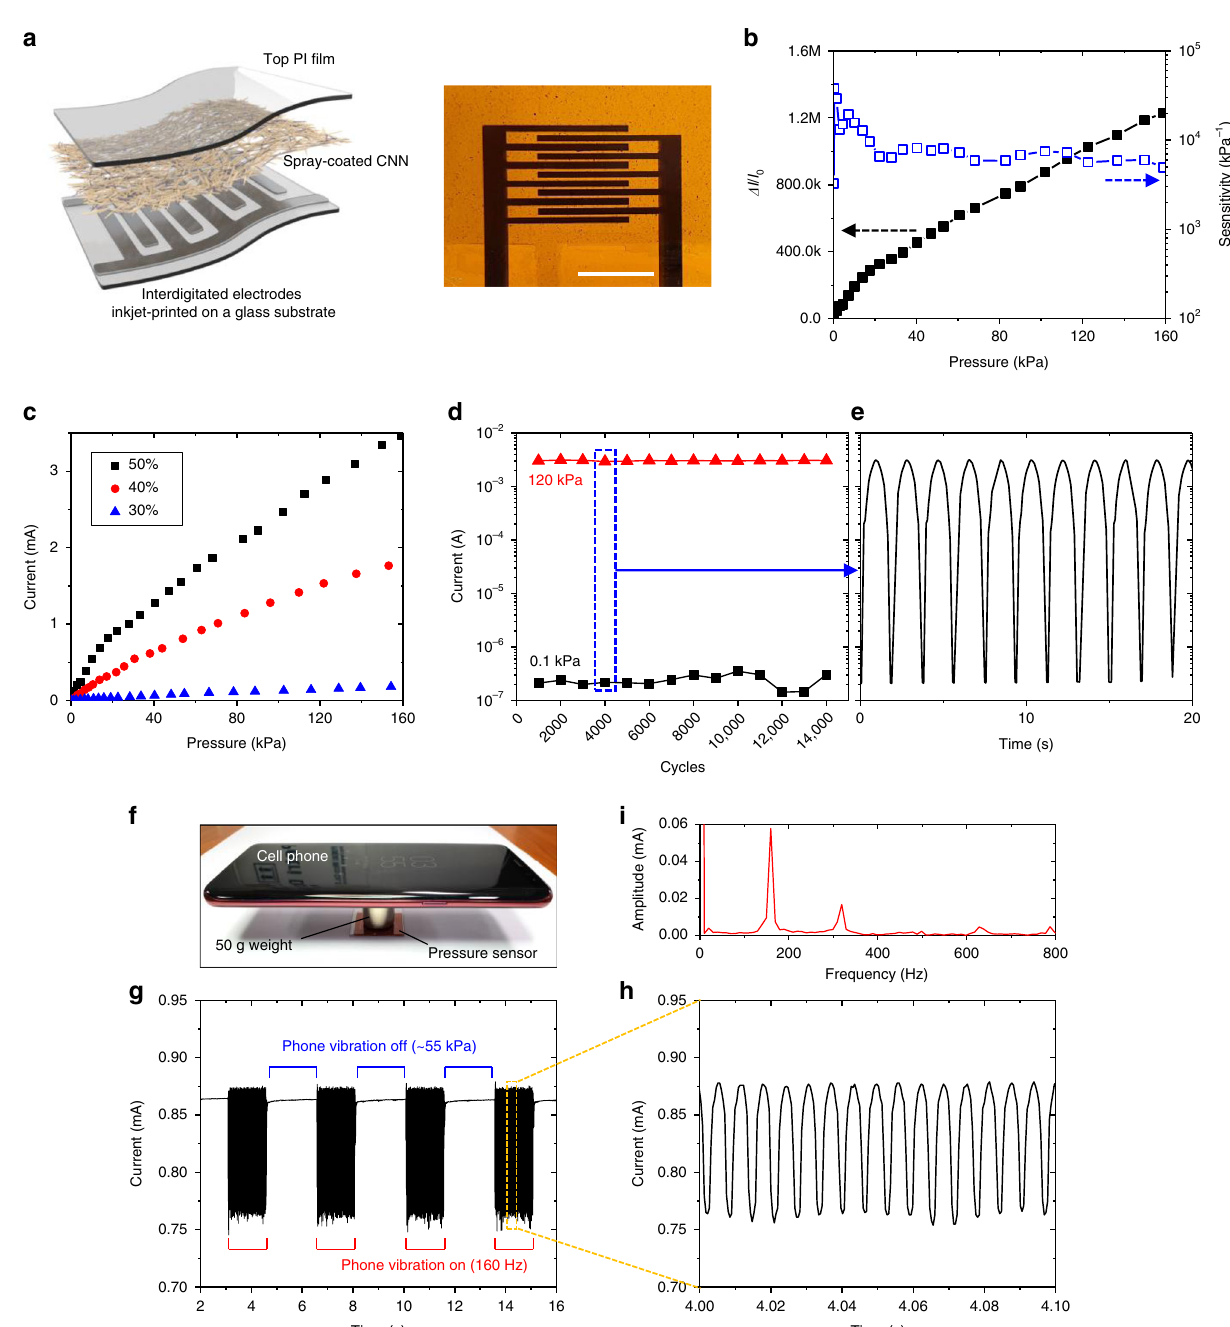
Fig. 2 Piezoresistive characterization of CNNs. a Structure of CNN-based pressure sensors for piezoresistive characterization. The photograph shows the fabricated pressure sensor. Scale bar, 5 mm. b Pressure response and sensitivity of the pressure sensor with the 0.9- μ m-thick CNN using a 50% volume ratio ink under a bias voltage of 1 V. c Plots of current as a function of the pressure applied onto CNN-based sensors using ink with three different volume ratios (30, 40, 50% v/v). d Cyclic stability of the CNN-based pressure sensor under continuous loading and unloading cycles from 0.1 kPa to 120 kPa. e Enlarged view of the recorded data in d after 4000 cycles. f Photograph showing the experimental setup for sensing cell phone vibration. g Sensing result of cell phone vibration (160Hz) using the pressure sensor. The current was recorded at a sampling interval of 480 μ s. h Enlarged view of the part of the current plot when the cell phone vibrated. i Fast Fourier transform result of the signal in h (>150 kPa), maintaining its ultrahigh sensitivity (>5000 kPa − 1 ) 0.9- μ m-thick CNN using a 50% volume ratio ink under a bias voltage of 1 V (see Supplementary Fig. 6 for a measurement method). The sensitivity is de fi ned as S = δ ( Δ I / I 0 )/ δ p , where p denotes the applied pressure, Δ I denotes the current change CNN was easily tuned by changing the volume ratio of the ink under the applied pressure, and I 0 denotes the initial current without pressure 14,33 . Our sensor showed a large sensing range